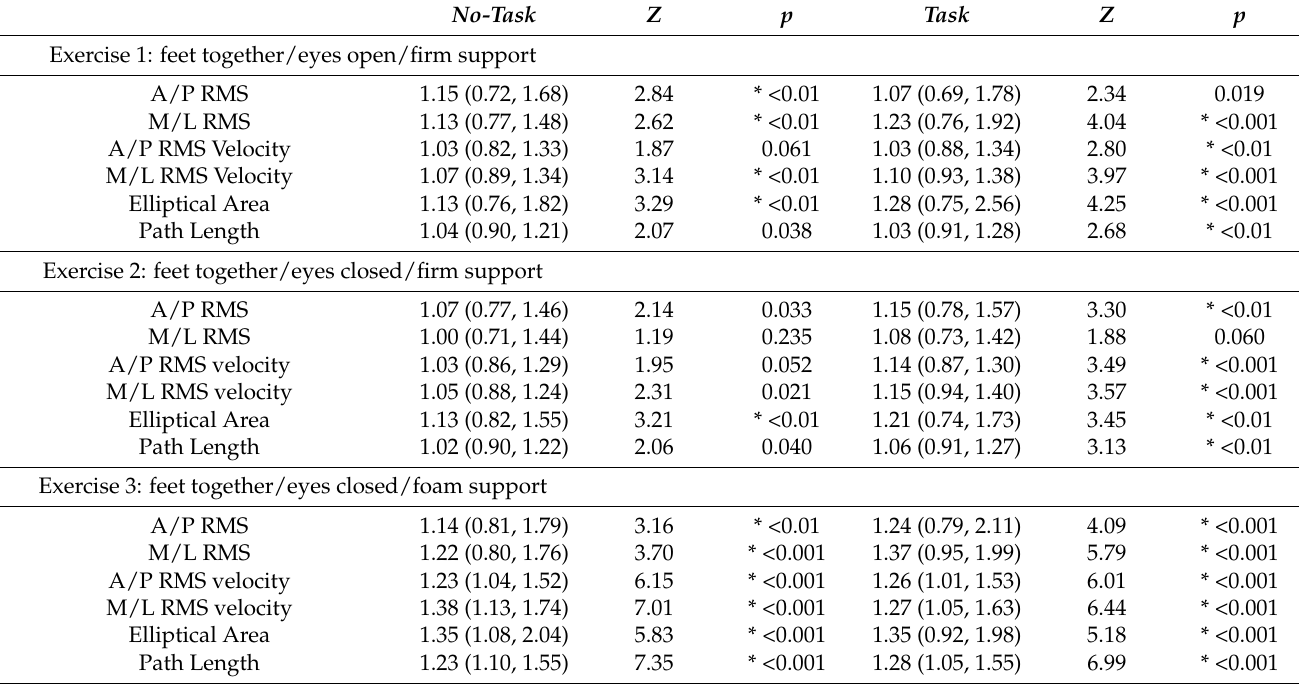
Table 1. Normalized values of the pre-post balance metrics for all exercises by Task condition. Median values (1st quartile and 3rd quartile) are shown. An asterisk (*) denotes a significant difference between pre-drive and post-drive postural sway for a specific Task condition.